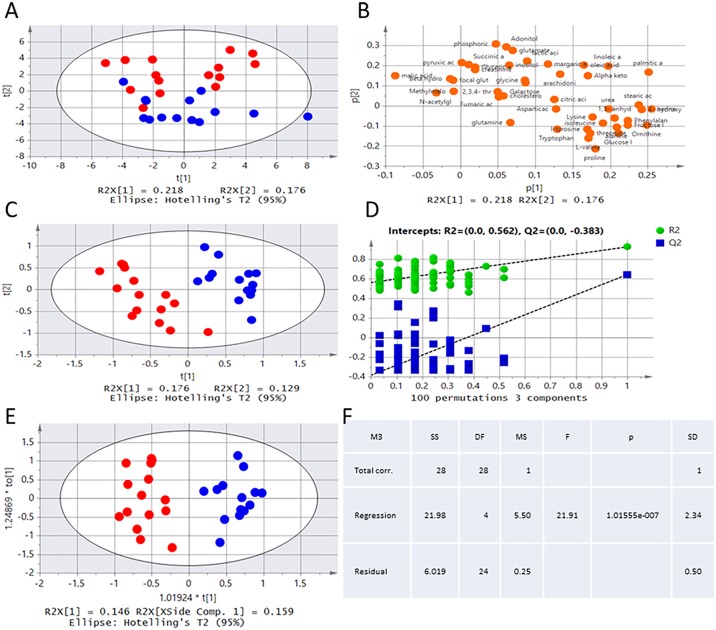
Multivariate presentation of the acute TBI (red) and sham groups (blue) by multivariate data analysis.(A) PCA of metabolites in the acute CCI and sham rat groups. (B) PCA loading of metabolite data. The metabolites had a major influence on the separation. (C) PLSDA of metabolites in the acute CCI and sham rat groups. (D) Validation plots of the PLSDA models acquired through 100 permutation tests for TBI vs health. (E) OPLSDA of metabolites in the acute CCI and sham rat groups. (F) Validation of the OPLSDA from an ANOVA of the cross-validated predictive residuals (CV-ANOVA). All data analysis was performed to indicate significant detectable differences between the acute CCI and sham rat groups.